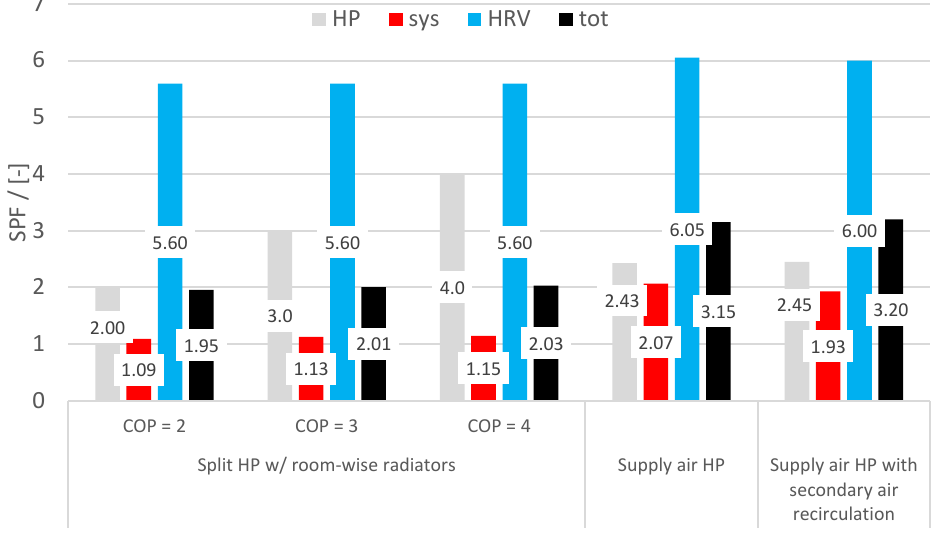
Figure 18. Annual (heating season) SPFs of the heat pump (“HP”), heating system (“sys”), HRV and total HVAC (“tot”), according to Equations (7) – (10) for the three investigated systems.